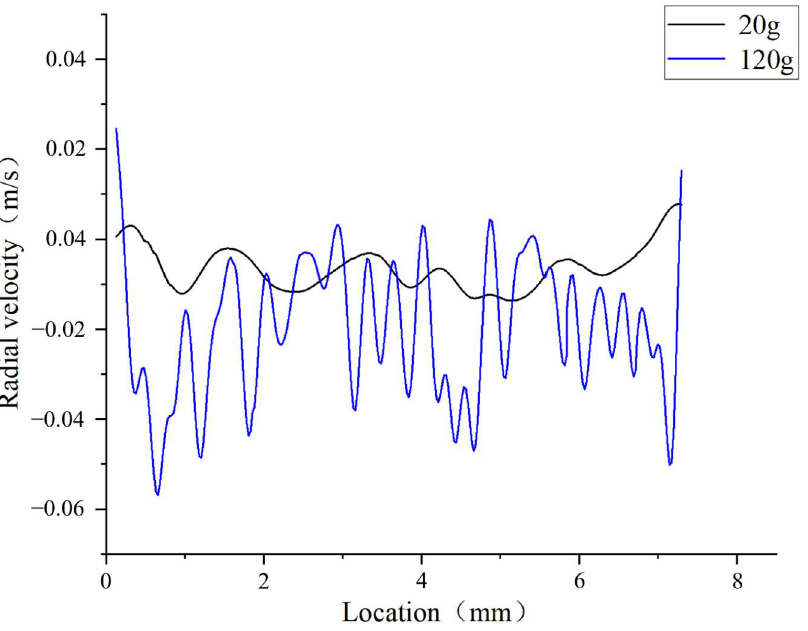
Figure 17. The distribution of the radial velocity along the axial direction (intermediate flow layer).